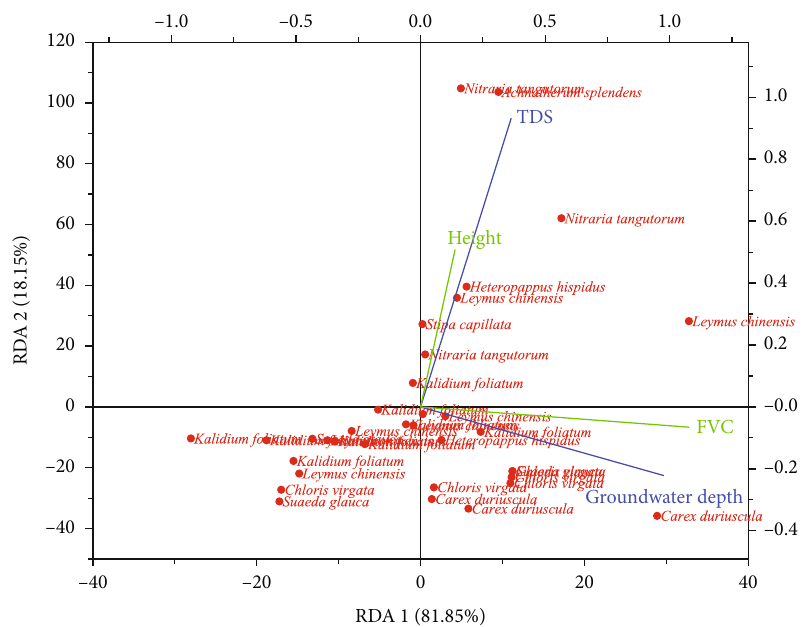
Figure 5: RDA of groundwater characteristics and natural